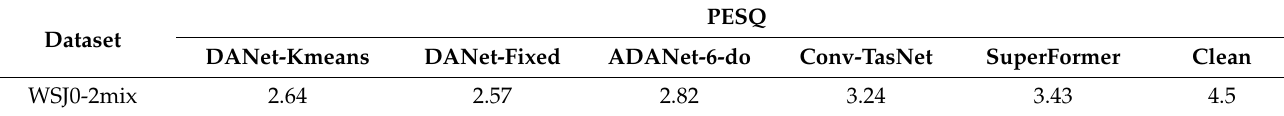
Table 2. PESQ scores on the WSJ0-2mix